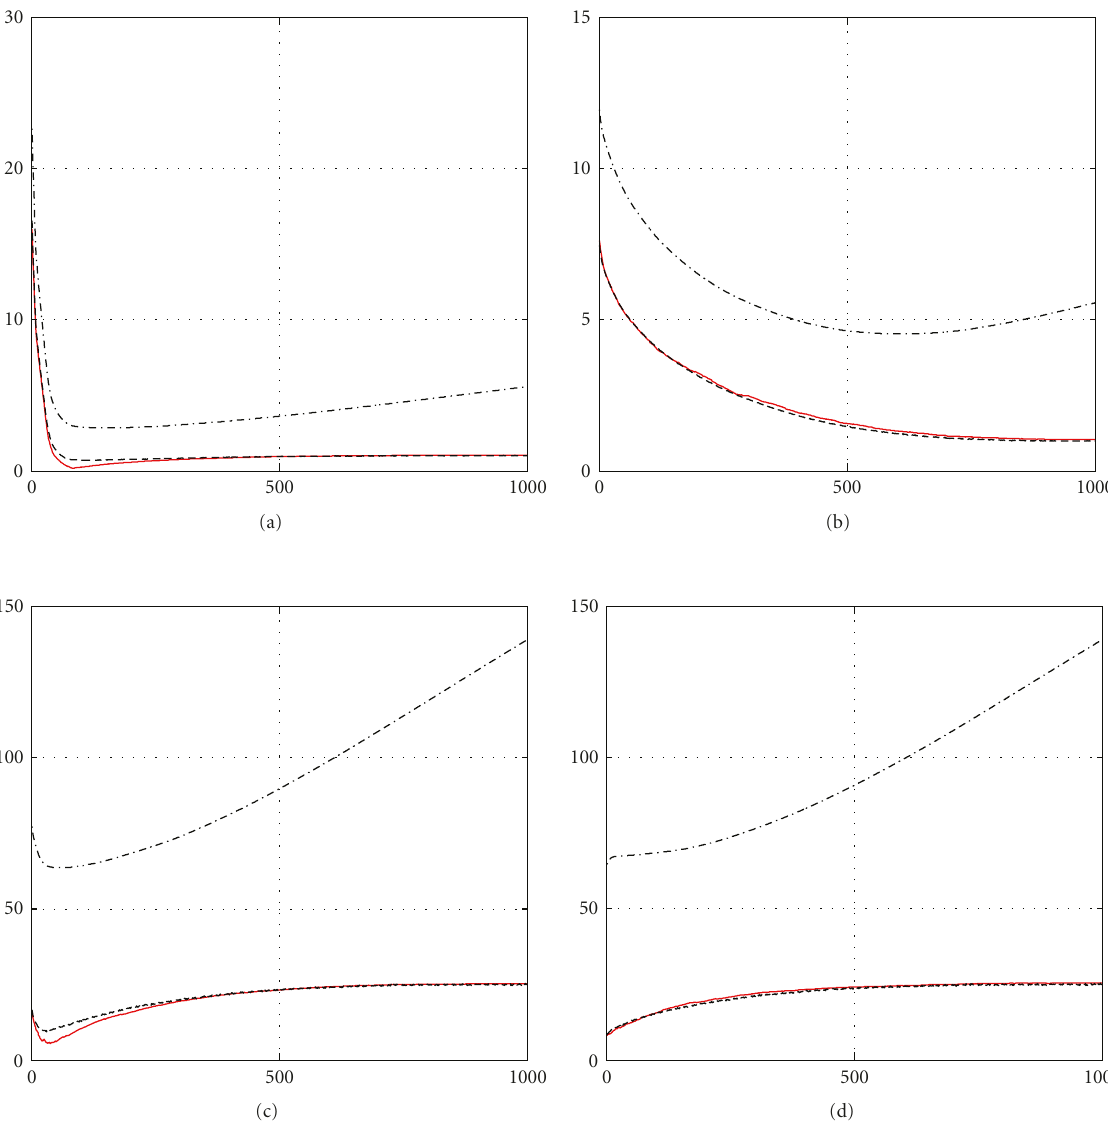
Figure 4: Desired unavailable MSE (solid red line), and its estimate using MNDL hard thresholding ( - - ) and MNDL-SS ( . - ) as a function of m . (a) Blocks signal with σ w = 1, (b) Blocks signal with σ w = 5, (c) Mishmash signal with σ w = 1, and (d) Mishmash signal with σ w =